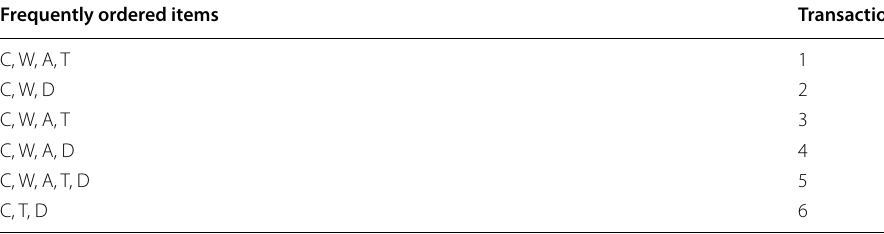
Table 4 A sample of DB after deleting 1 single pattern and descending order [25] Frequently ordered items